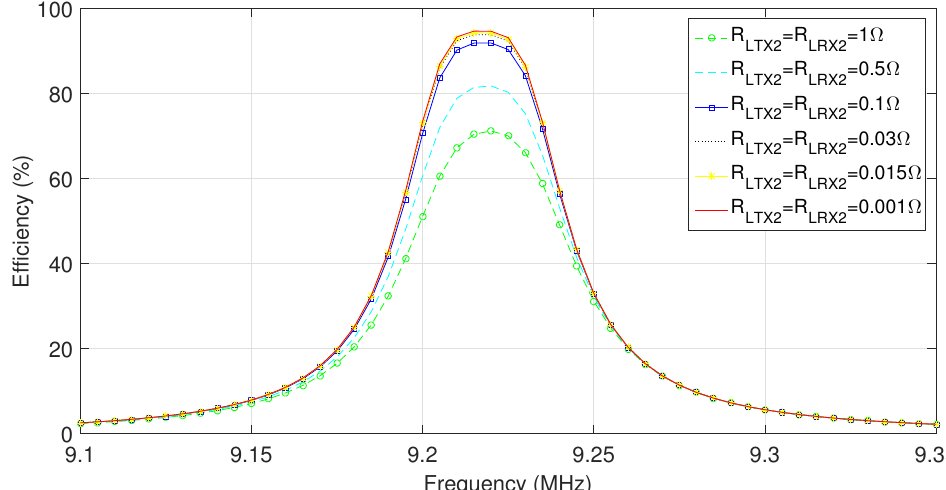
Figure 10. Effect of different resistance of added coils on the systems efficiency. The smaller the resistance, the higher the efficiency and vice-versa.